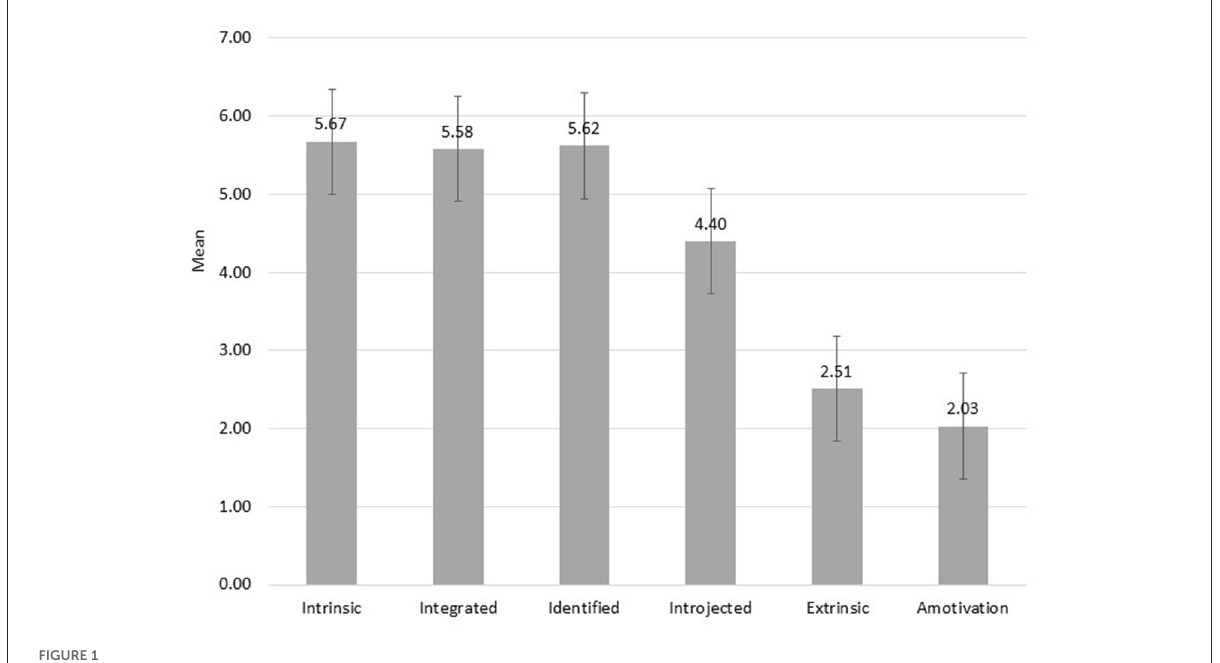
FIGURE1 Motivation levels among the varsity athletes.